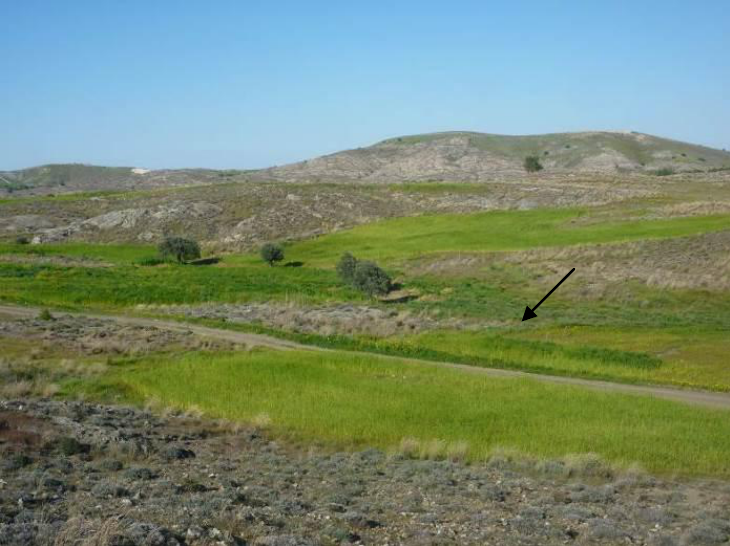
Figure 1. Photo taken from the archaeological test field in Alampra, Cyprus (WGS 84, 36°N: 535051, 3870818). Formation of crop marks is shown in the photo with an